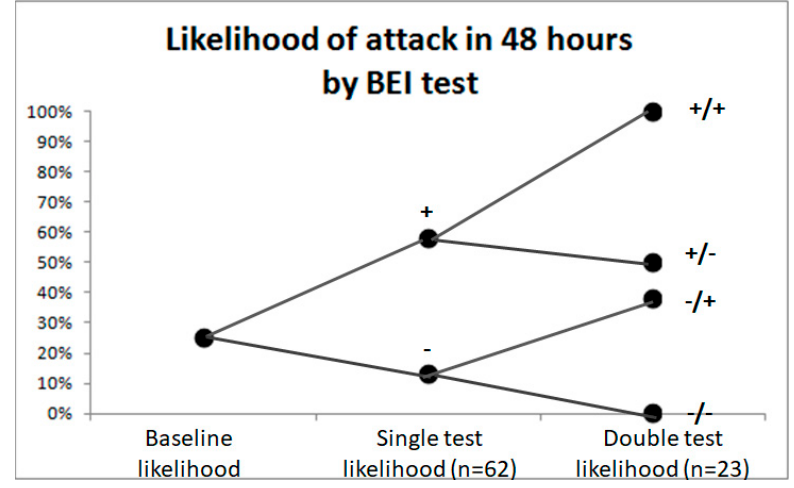
Figure 5. Likelihood of migraine attack in 48 h according to the BEI test.